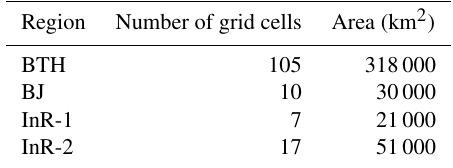
Table 3. Information on the four emission reduction regions.